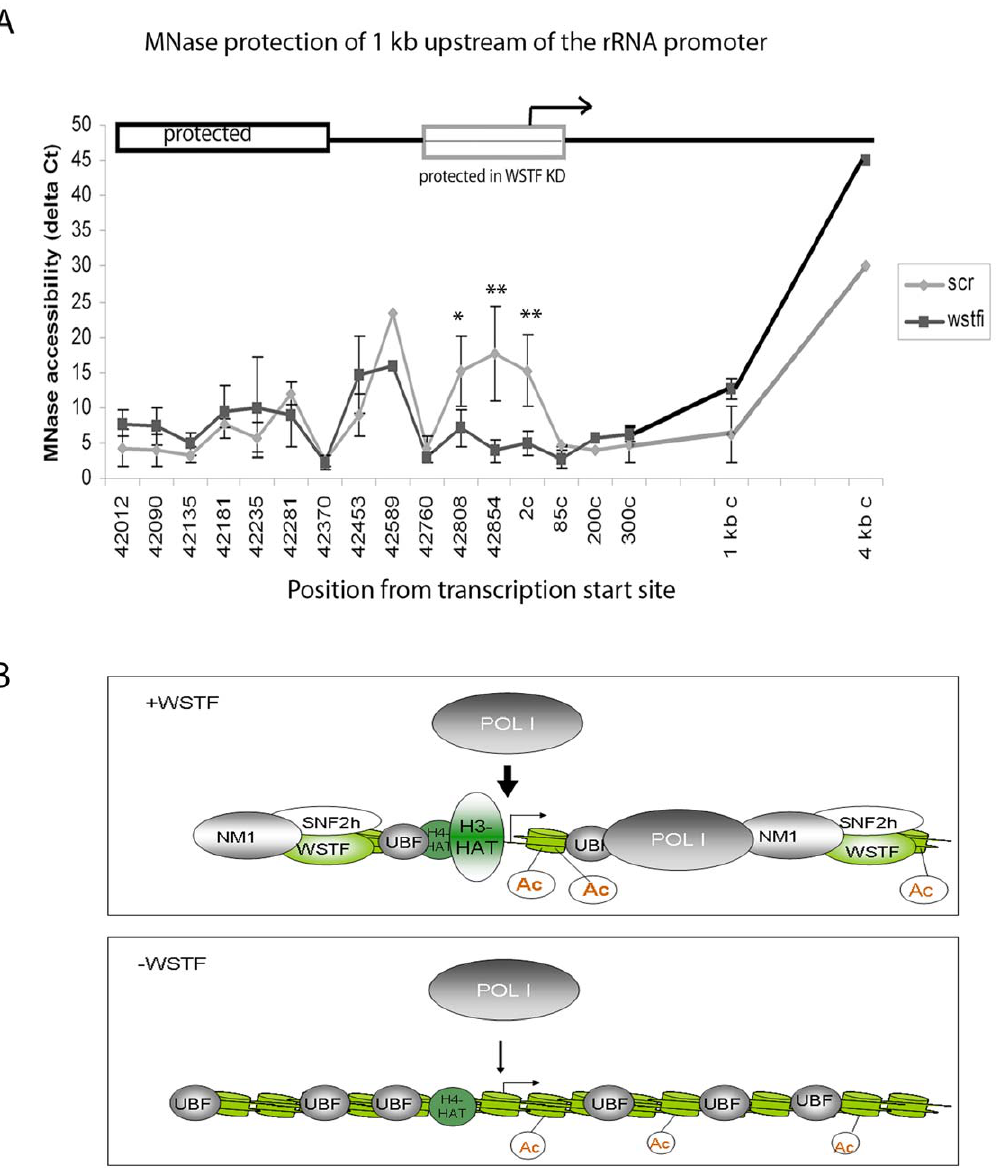
Figure 6. WSTF affects a 200 bp region at the rRNA promoter. A ) The chromatin profile from WSTF KD cells (black line) and scrambled cells (grey line) presented as 2 D Ct of undigested and MNase digested cross-linked chromatin The position of the primer pair used is given below the graph; 2c (coding) denotes position 2 in the coding region. Error bars represent standard deviations of three separate experiments. *: p=0.05, **: p=0.02 (Student t-test, two-sample equal variance). The graph is not drawn to proportion. The gene region is depicted above the graph, showing protected areas in boxes. The region specific to the effect of WSTF KD is marked with a grey box. The arrow indicates transcription start site. ( B ) Schematic model of the role of B-WICH in rRNA transcription. The B-WICH complex is required for the access of B-WICH factors and H3-specific histone acetyl- transferases to the DNA, resulting in H3K9-acetylation.